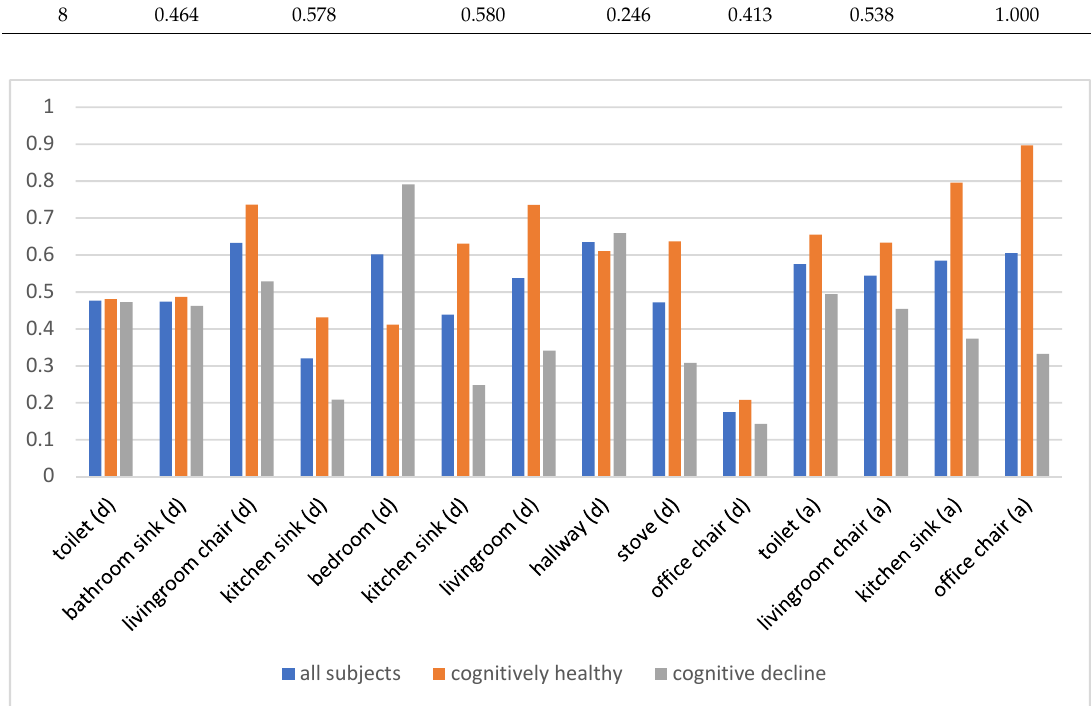
Figure 5. Weights of location-based duration (d) and activity level (a) features learned using the RRE-IRL algorithm.